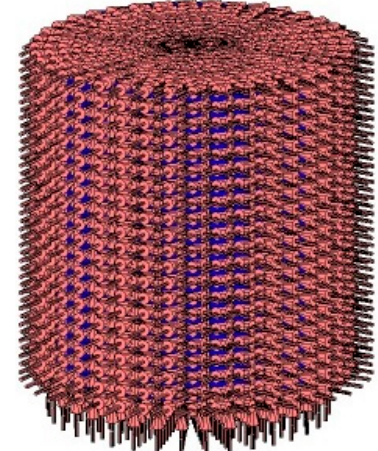
Figure 2. Magnet with coil current and magnetic potential of magnet.